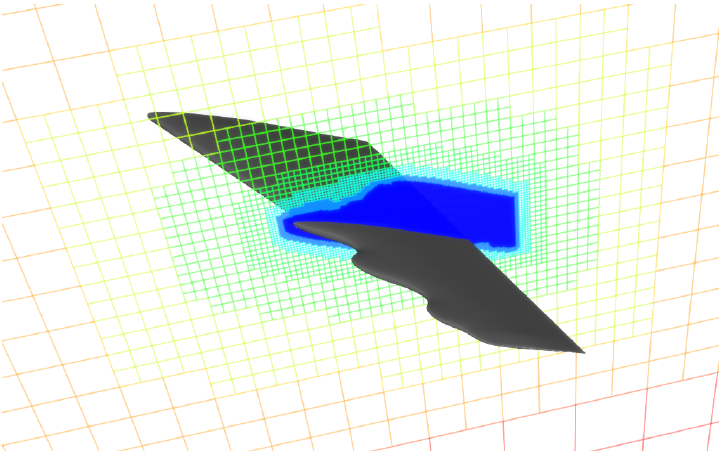
Figure 1. Octree lattice structure with different lattice